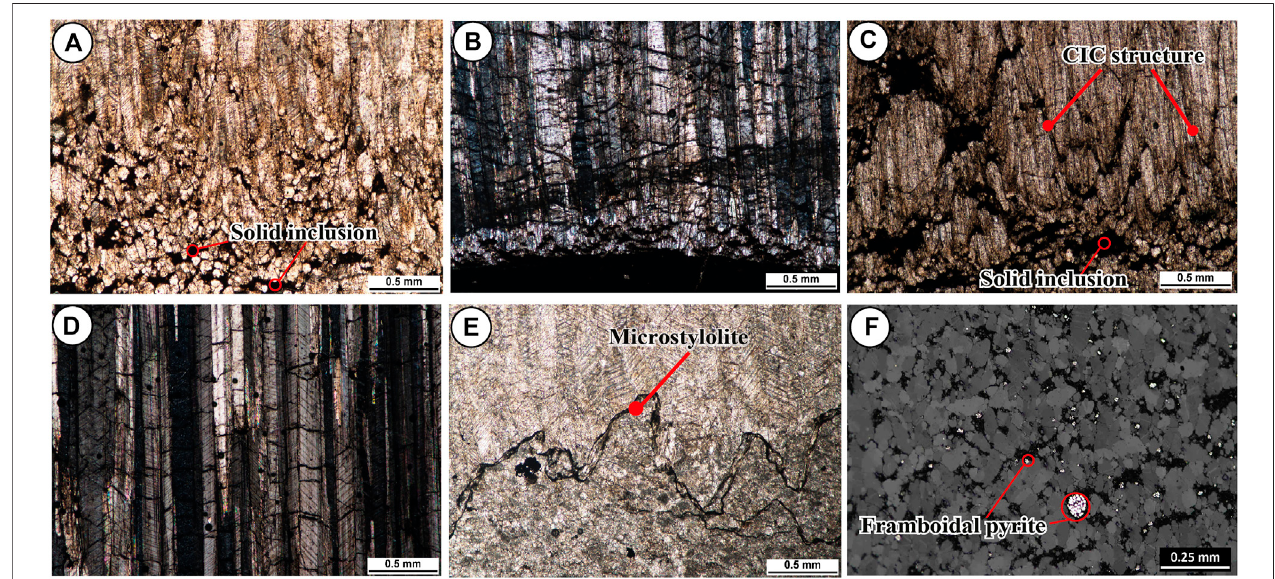
FIGURE3| PhotomicrographsoftheKhaoKhwangFormation. (A) Solidinclusionsinthe fi brouscalciteveinandachangefromequantcalciteto fi brouscalcite; (B) achangefromcone-in-conetobeefveintextures; (C) beefveinsintheKhaoKhwangsamples; (D) cone-in-coneveinsarecommonlyfoundintheKhaoKhwangsamples and are characterized by a nested cone geometry; (E) microstylolite; and (F) framboidal pyrite is common in the host rock matrix.